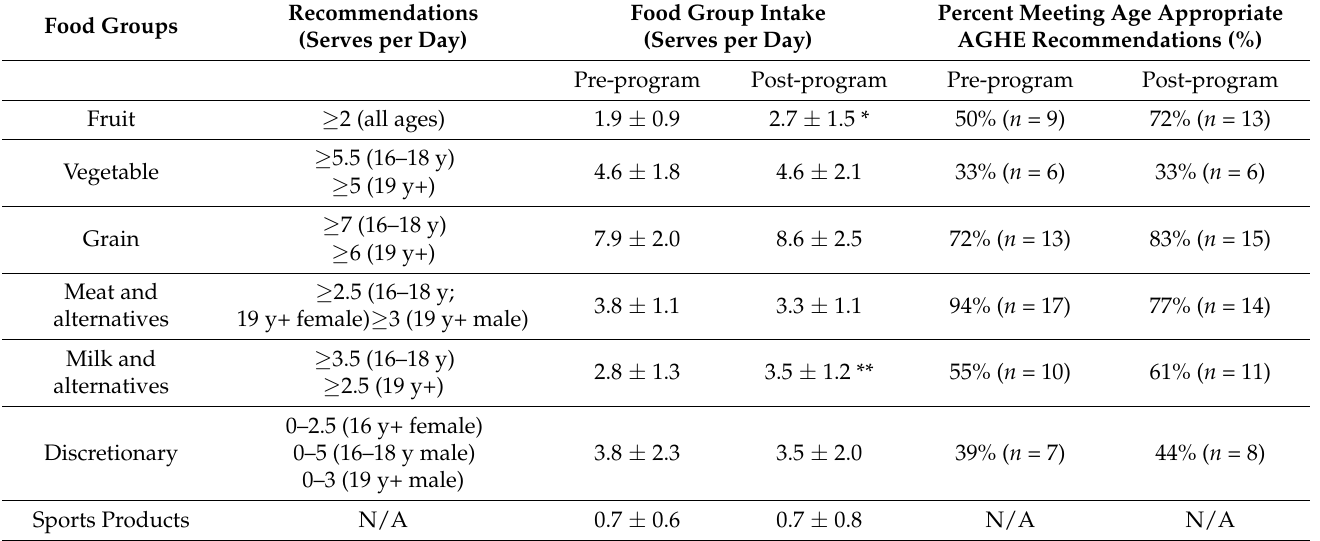
Table 4. Food group intakes of junior elite triathletes (mean ± SD) as per Australian Guide to Healthy Eating (AGHE)